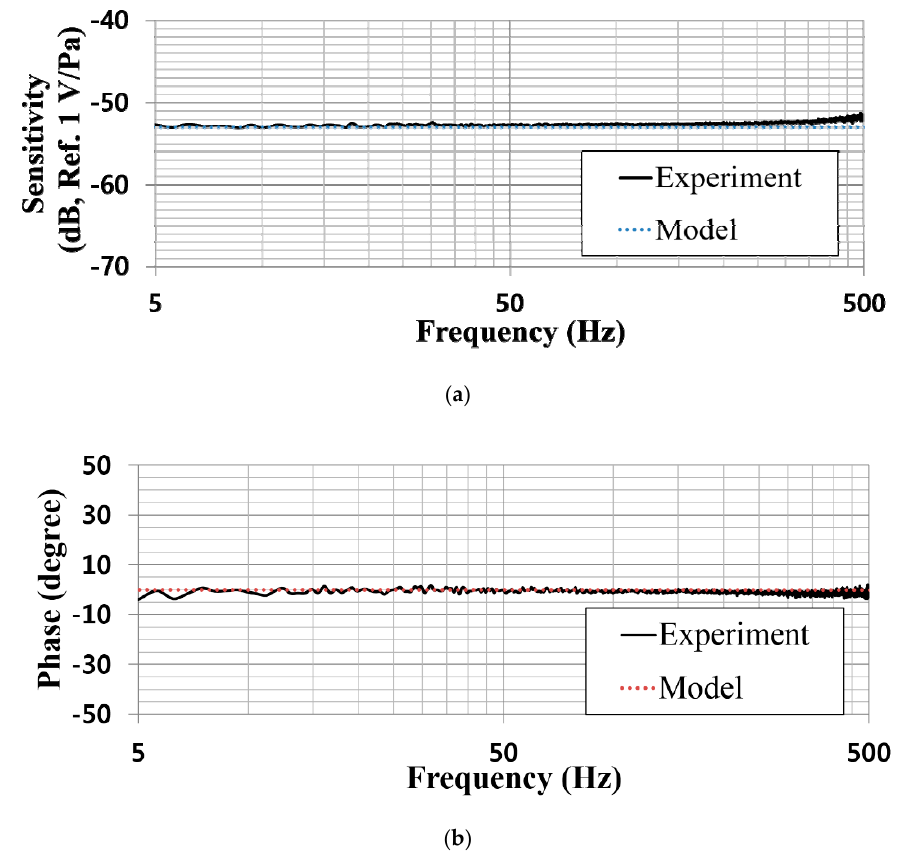
Figure 12. Frequency response of the ElGoFET microphone: ( a ) sensitivity and ( b ) phase.